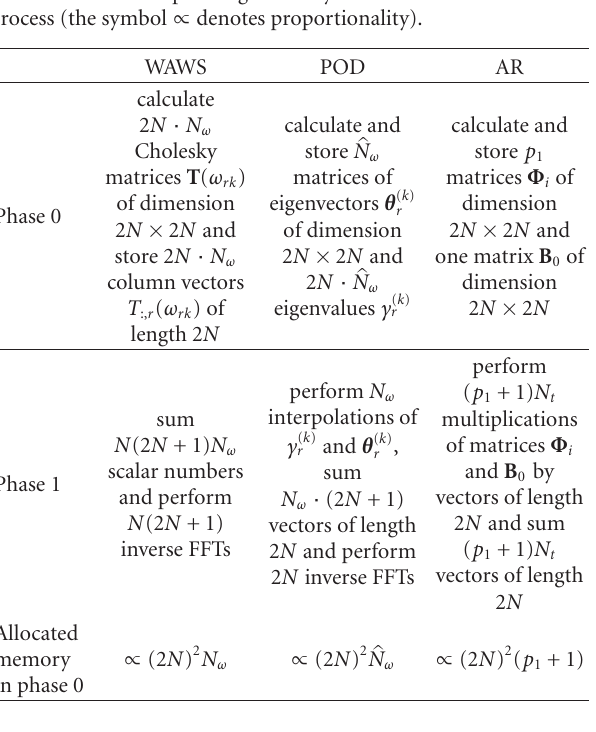
Table 2: Comparison between peak values of samples generated using the three simulation methods.